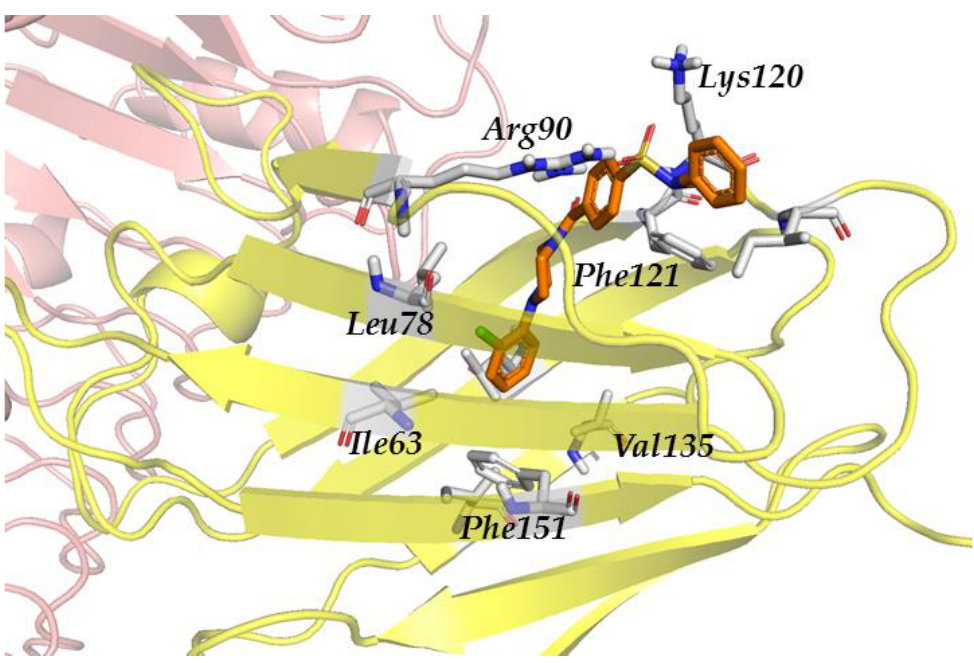
Figure 3. Redocked ID 5382 (orange sticks) in TLR4/MD-2. MD-2-interacting residues are highlighted with grey sticks. TLR4 is depicted in pale pink, MD-2 — in yellow.